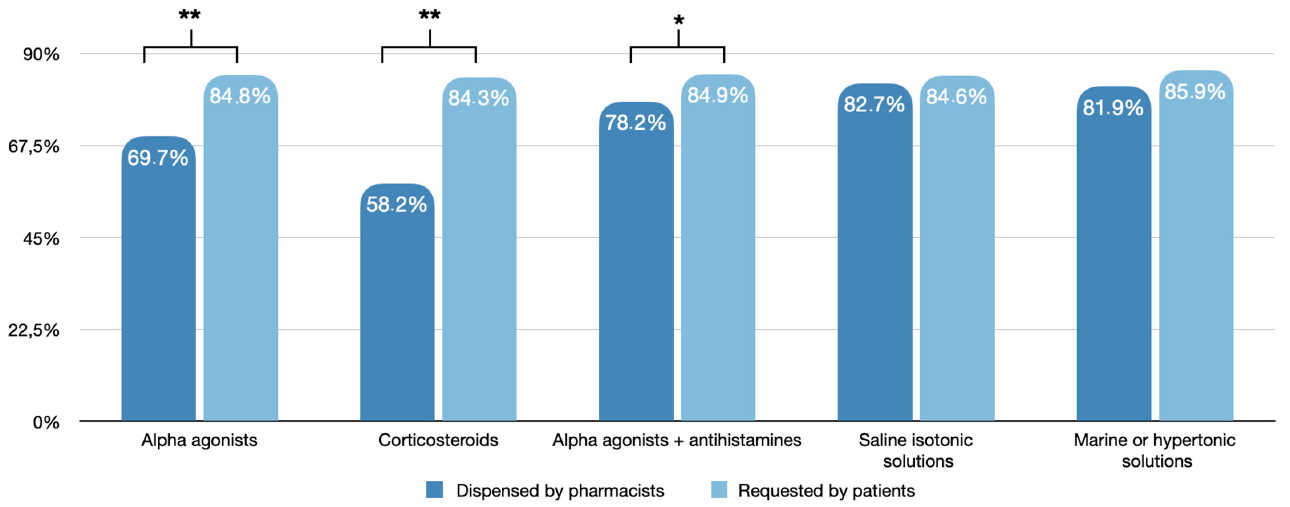
Figure 3. Difference between pharmacists’ prescriptions and customers’ queries of decongestant nasal sprays stratified by type of molecules (* = p < 0.05; ** = p < 0.01).